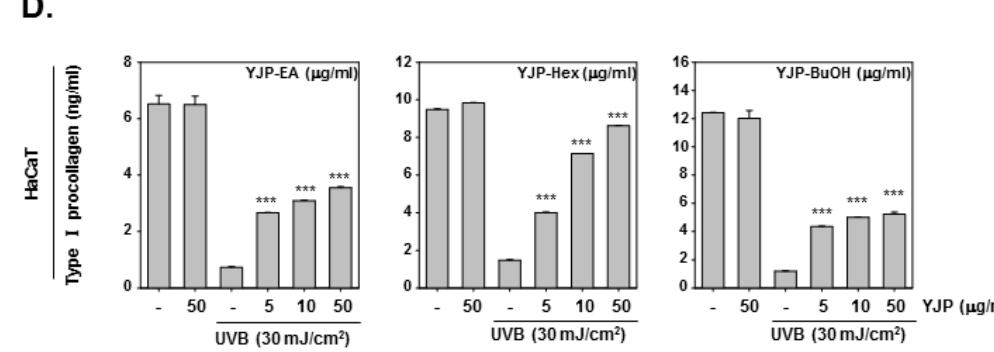
Figure 1. Anti-wrinkle effects of YJP-EA, Hex, and BuOH on UVB-irradiated human keratinocyte HaCaT cells. ( A ) HaCaT cells were treated with YJP-EA, Hex, and BuOH for 24 h. An MTT assay was performed to evaluate cell viability. ( B ) HaCaT cells were irradiated with UVB (30 mJ/cm 2 ) and then treated with YJP-EA, Hex, and BuOH for 24 h. Whole cell lysates were analyzed by Western blot analysis. ( C ) HaCaT cells were treated by YJP-EA, Hex, and BuOH for 24 h after UVB (30 mJ/cm 2 ) irradiation. The RNA level was evaluated using reverse transcription PCR. ( D ) The Pro-Collagen of HaCaT cells was measured using an ELISA kit, following the manufacturer’s instructions, with 450 nm. All experiments were performed individually in triplicate. *** p < 0.001 vs. non-treated (NT) cells, ** p < 0.01 vs. non-treated (NT) cells, and * p < 0.05 vs. non-treated (NT)